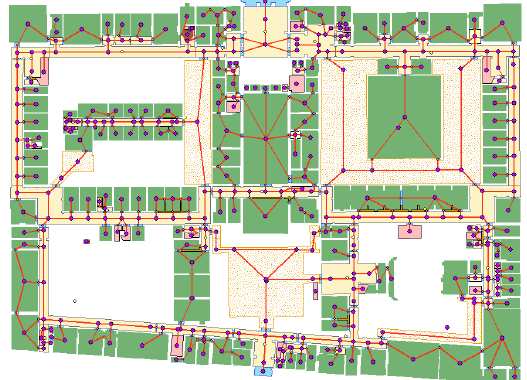
Figure 4: Floor plan of the ground floor with network visualization.